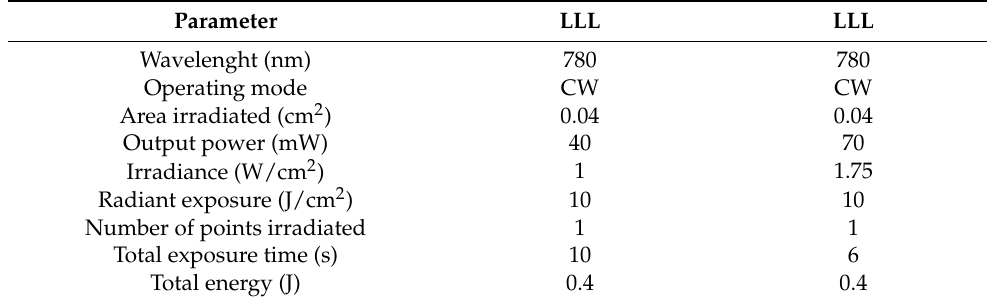
Table 1. PBM parameters (LLL).